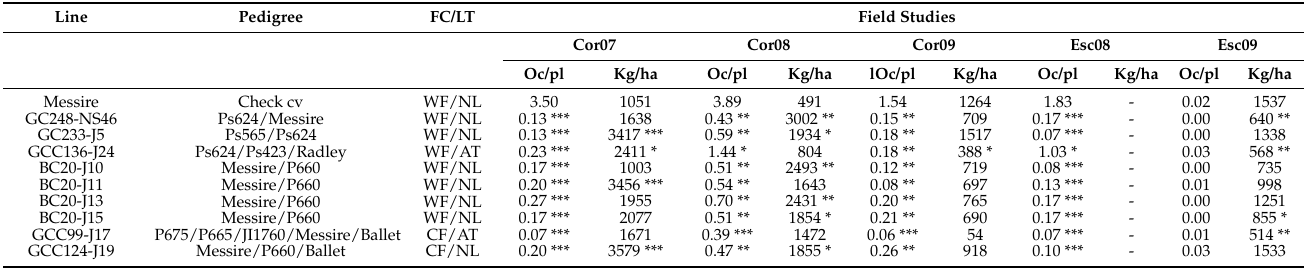
Table 1. Field response of pea breeding lines to Orobanche crenata compared to the parental cv. Messire.